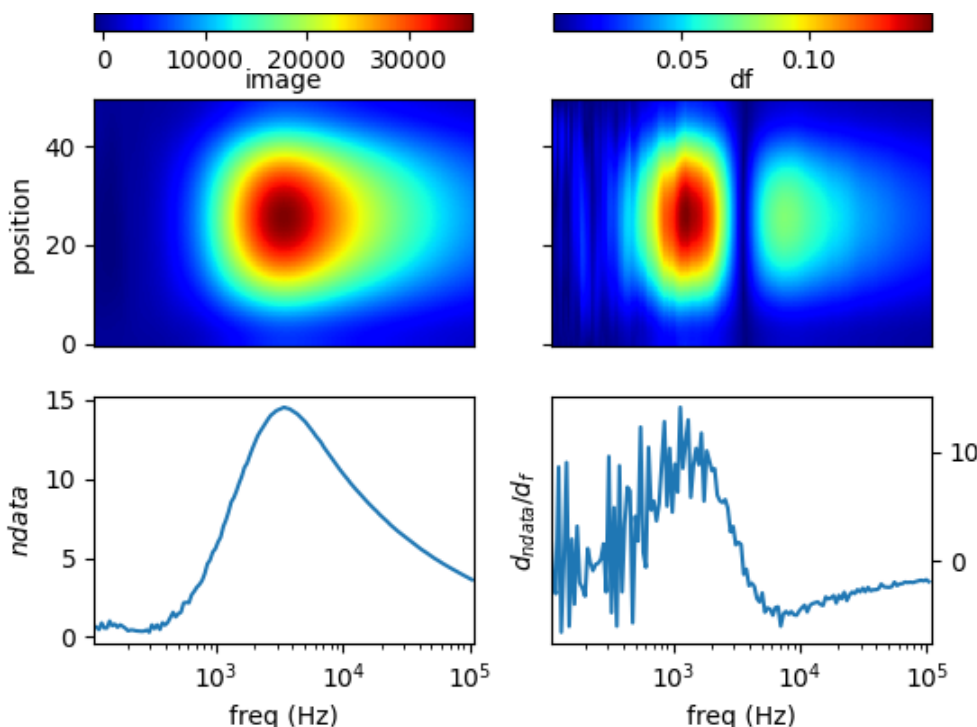
Figure 12. Spectral profile and its derivative (data and reconstructed image values) for a 0.25 inch aluminum rod (σ = 26.3 MS/m) .